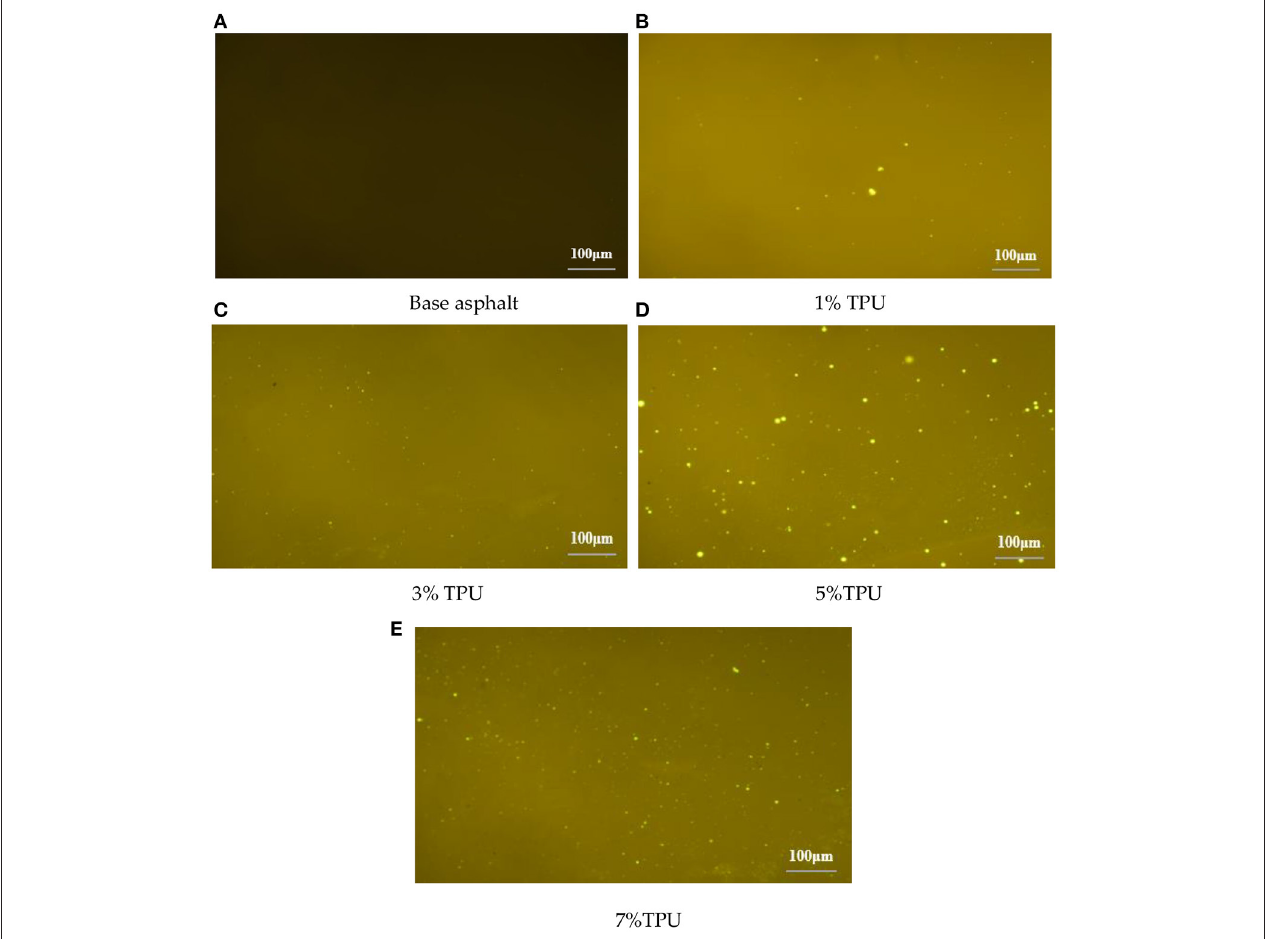
FIGURE 18 | Fluorescence micrographs of polyester-based TPU-modified asphalt. (A) Base asphalt. (B) 1% TPU. (C) 3% TPU. (D) 5%TPU. (E) 7%TPU.